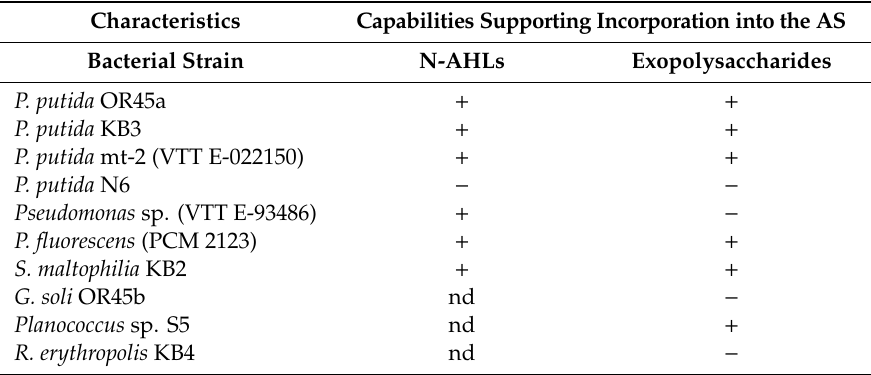
Table 2. Production of N-AHLs and exopolysaccharides by the tested strains. Characteristics